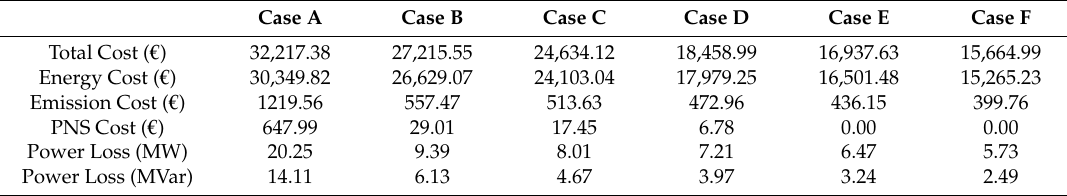
Table 6. The total expected costs of the objective function and power losses. PNS: Power Not